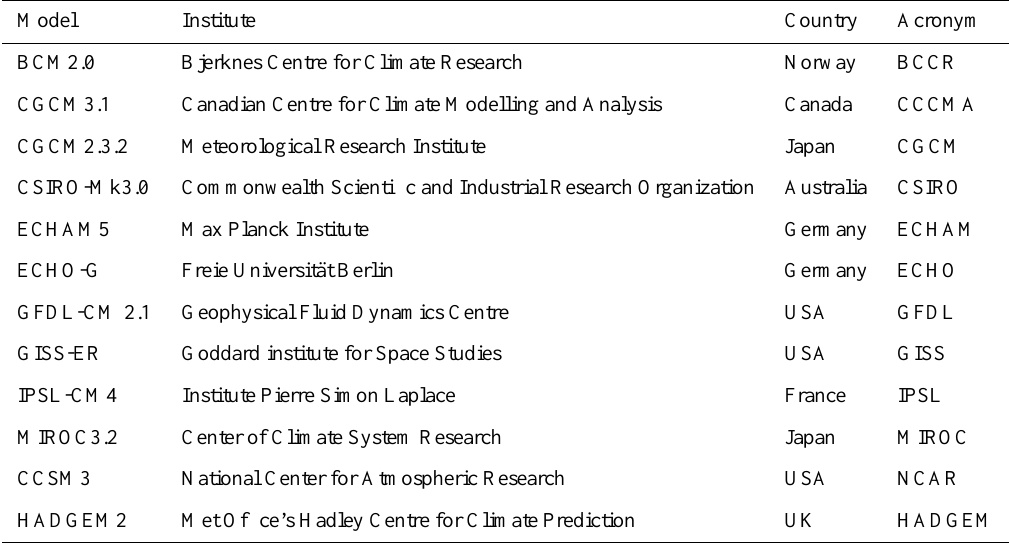
Table 1. Overview of selected GCMs.